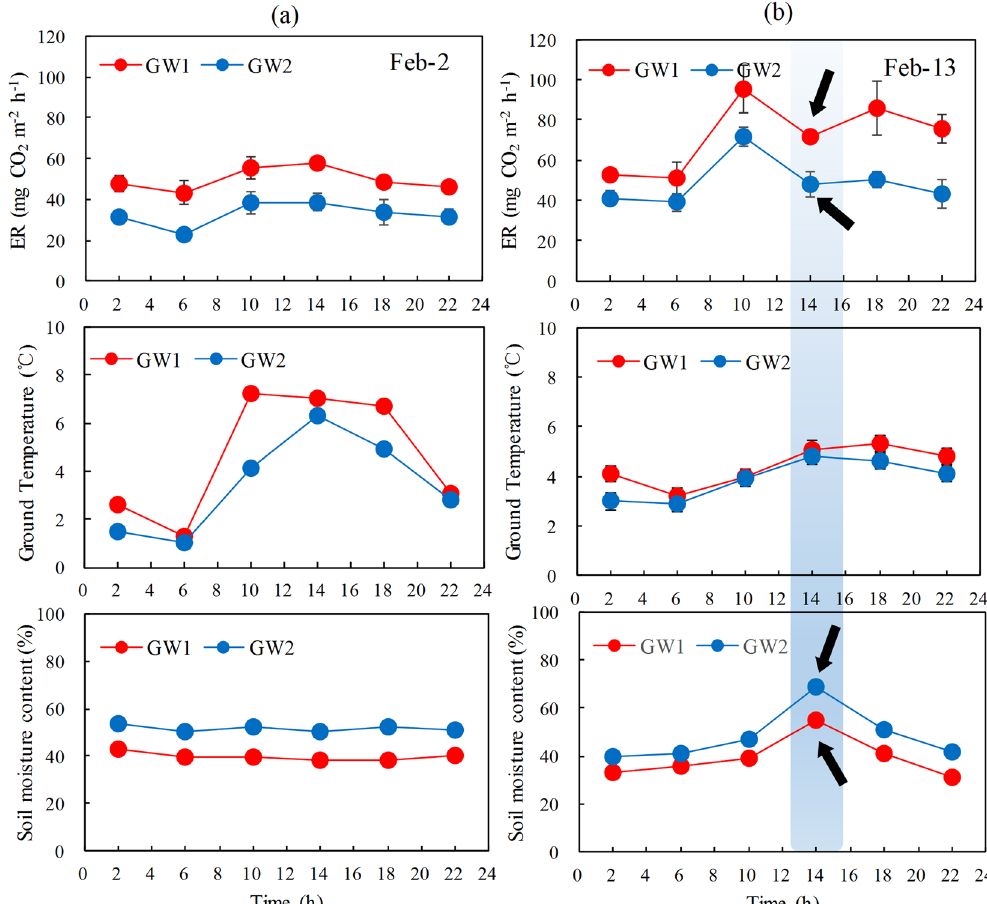
Figure 4. Diurnal variations of tundra ER, soil temperature and soil moisture at the tundra sites GW1 and variability in tundra ER. Topography is the primary determinant of soil moisture patterns across arctic landscapes and plays a major role in determining the distribution of vegetation types and plant community succession 29 . The variation in plant biomass, rates of primary productivity, soil organic matter (SOM) quantity and quality, nutrient status and soil chemistry are all tightly linked to topography 30 . In total, topography results in spatial variations in environmental variables through establishing elevation gradients, and in turn influences the rates of tundra carbon transformation processes. In our study area, soil temperature increased with the elevation from GW3 to GW1, but soil moisture significantly decreased with the elevation. Our results indicated that topography gradient plays critical roles through their influences on soil moisture, soil temperature and their interaction that in turn affect ER and C biogeochemical cycling in the tundra ecosystems of maritime Antarctica. On the other hand, corresponding topographical gradients of soil moisture and temperature tend to occur at the landscape and larger spatial scales across the Arctic 31 . In maritime Antarctica, tundra ecosystems generally developed on the elevated, hilly and uneven upland along the coast. Faster rates of organic matter mineralization and decomposition (i.e. CO 2 emissions) occur in inter-hummock areas 13,30 . In this study, higher soil moisture and lower temperature occurred at the slope site GW3 which might limit soil organic matter decomposition by microorganisms, resulting in soil organic matter accumulation in low-lying areas 30 . Therefore topography is a key factor for the evaluation of tundra ER at the tundra landscape and larger spatial scales in maritime Antarctica. The temporal variation range of ER (34.9 to 127.2 mg CO 2 m − 2 h − 1 ) was considerable as tundra ER varied with soil temperatures (Fig. 2). The ER rates showed a similar diurnal pattern at the top site GW1 and the slope site GW2, corresponding to ground temperature (Fig. 4). It was demonstrated that there was a diurnal cycle both of tundra photosynthesis and respiration in the Antarctic Peninsula 12 , and our results corroborated previous research. Overall the ER rates showed a significant positive correlation (P < 0.05) with soil temperatures in mar- itime Antarctic tundra (Fig. 3a). The activities of soil or plant enzymes and soil microorganisms were gradually enhanced with the increase in soil temperatures, and then led to increased ecosystem respiration rates, whereas the low temperature would restrict the respiration of the vegetation and soil microorganisms, thus reduced tundra ER rates 9,12 . Similarly, the ER generally showed a strong positive correlation with soil temperature in Arctic tun- dra, and climate warming might decrease CO 2 sink through increase in tundra ER 9,32 . In McMurdo Dry Valley of east Antarctica, several studies also showed a similar correlation between ER and soil temperatures 10,33 . Overall